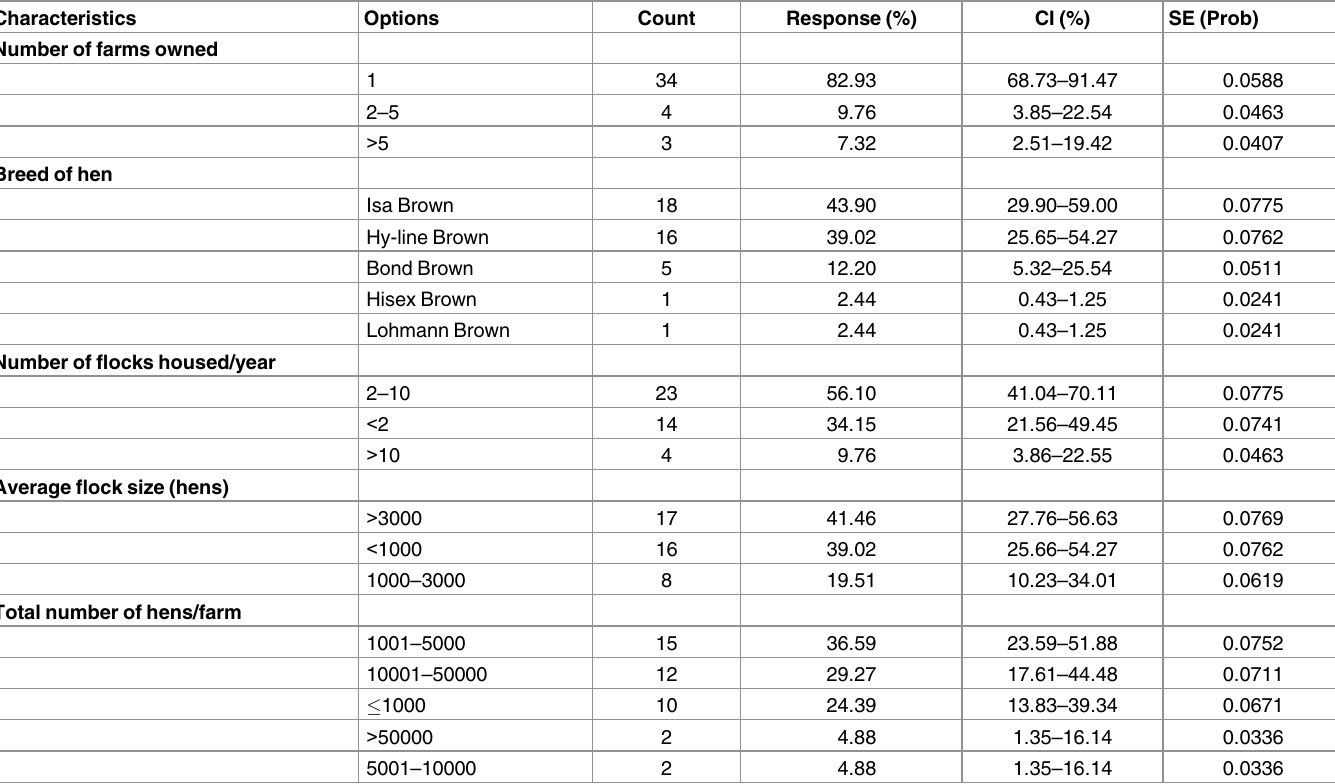
Table 2. Farm and flock characteristics of respondent free-rangeegg farms with an outdoor stocking density of (cid:20) 1500 hens/hectare.